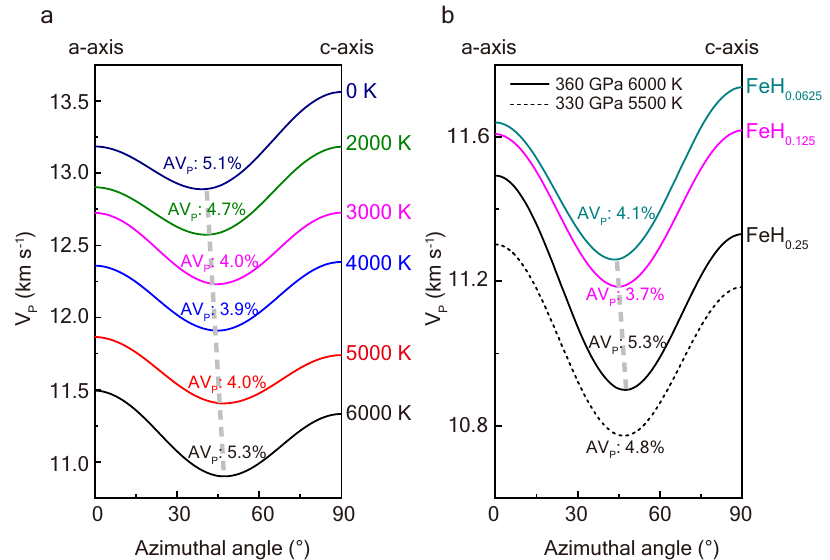
Fig. 1 | Seismic wave velocity anisotropies in hcp-FeH 0.25 . a The velocity aniso- tropies(AV P )in FeH 0.25 at360GPaand 0 – 6000K. Differentcolorcurvesrepresent velocitiesattemperaturesfrom0to6000K,notingthepercentageoftheAV P .The azimuthal angle of 0° corresponds to the velocity along the a-axis, while 90° cor- responds to the c-axis. b The velocity anisotropies in Fe-H alloys with different H